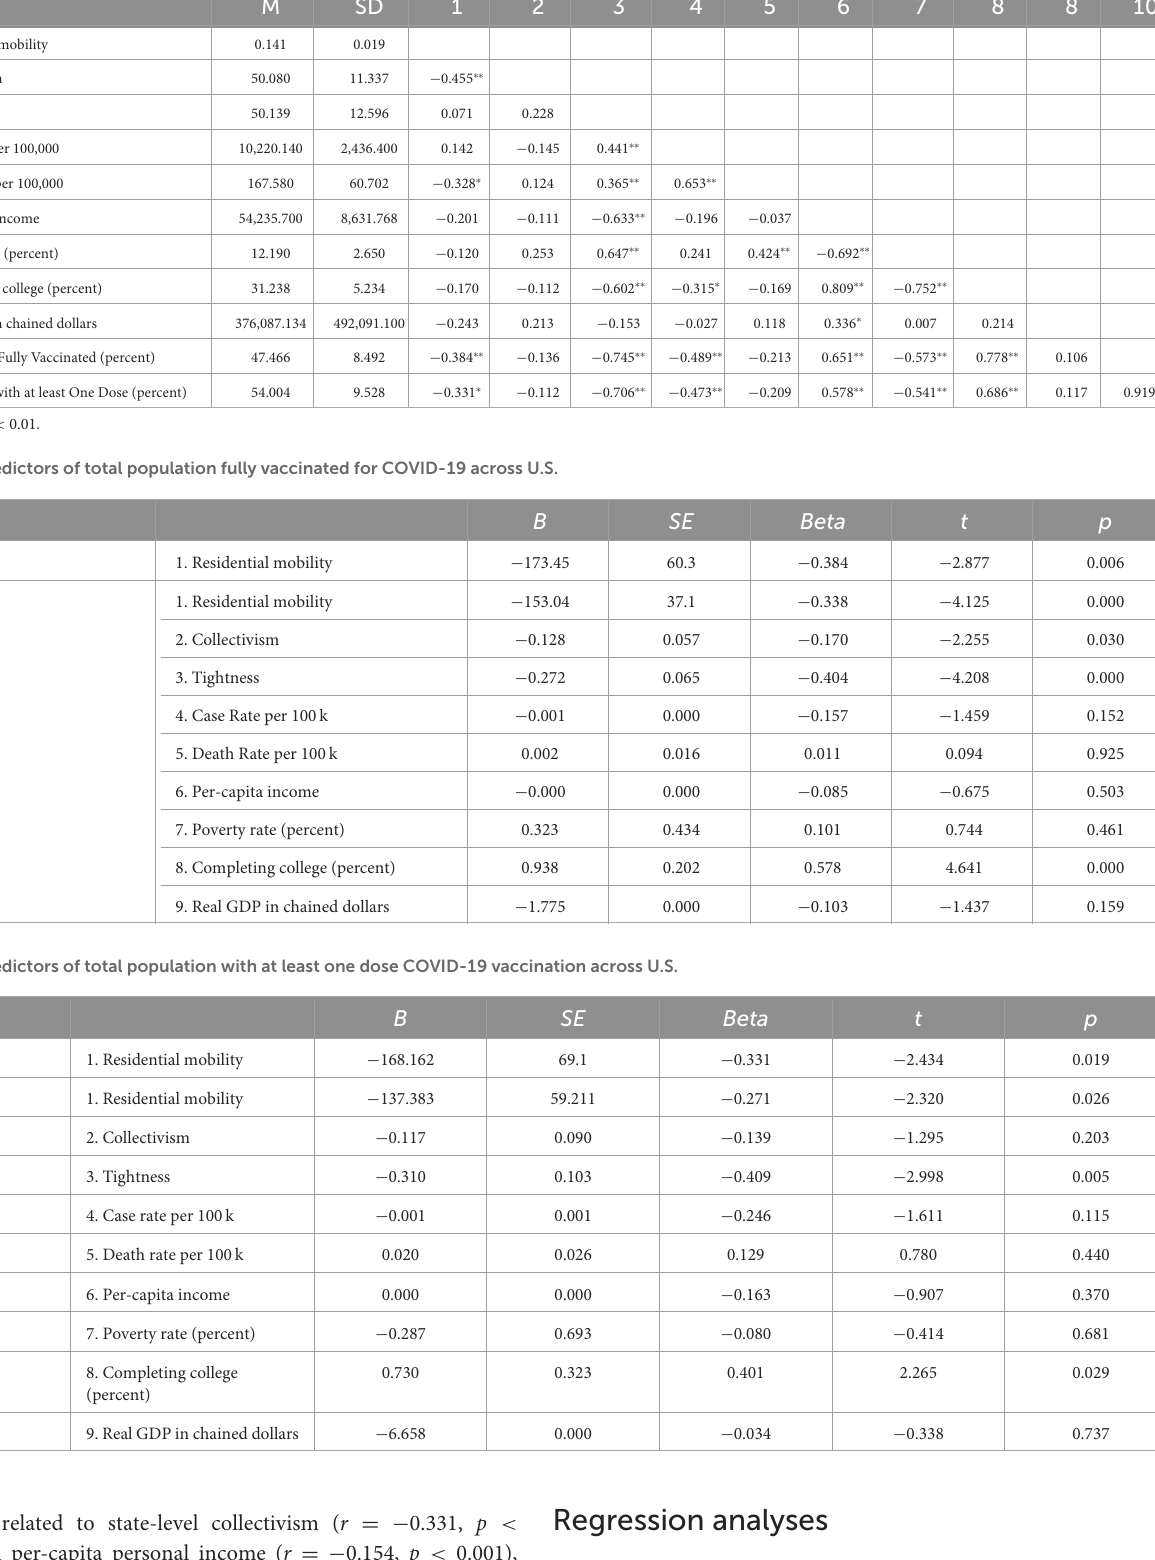
Regression analyses Regression analyzes showed that residential mobility negatively predicts flu vaccination coverage estimate of all age groups in general ( B = − 0.789, SE = 0.117, t = − 6.77, p <